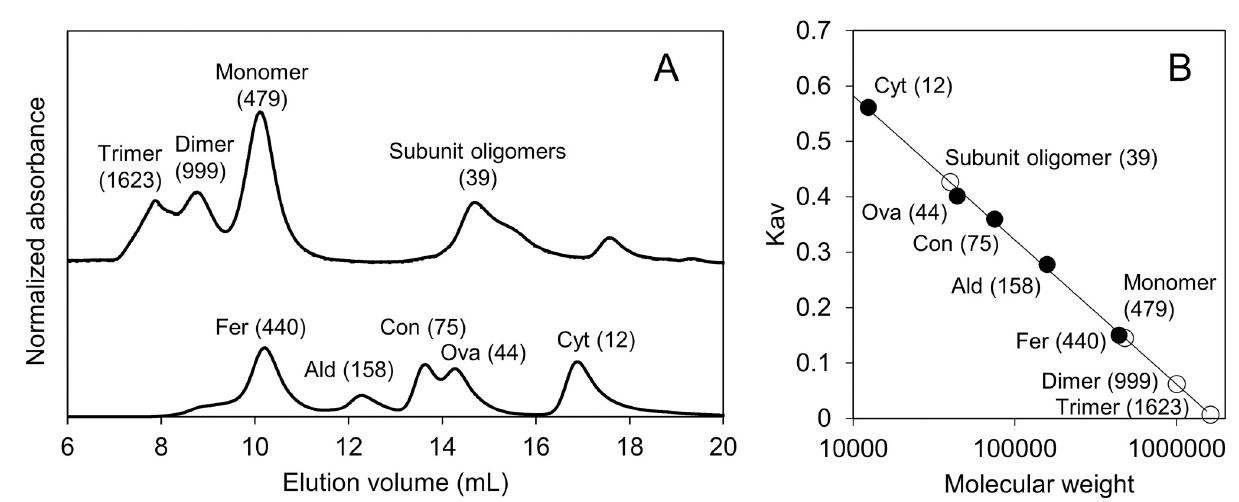
Fig 5. SEC analysis of the solution obtained after heating the apoferritin hydrogel at 90˚C for 30 min. (A) Chromatograms of the solution obtained after heating the apoferritin hydrogel and of standard proteins (ferritin, 440 kDa; aldolase, 158 kDa; conalbumin, 75 kDa; ovalbumin, 44 kDa; cytochrome c , 12 kDa). (B) Standard curve obtained by least-square fitting of the partition coefficient (Kav) plots of standard proteins (closed circles). Peaks obtained in the chromatogram of the solution obtained by heating the apoferritin hydrogel are labeled with the molecular size (kDa) estimated by the standard curve. The plots of the apoferritin hydrogel after heating (open circles) are depicted with the estimated molecular weight (kDa).